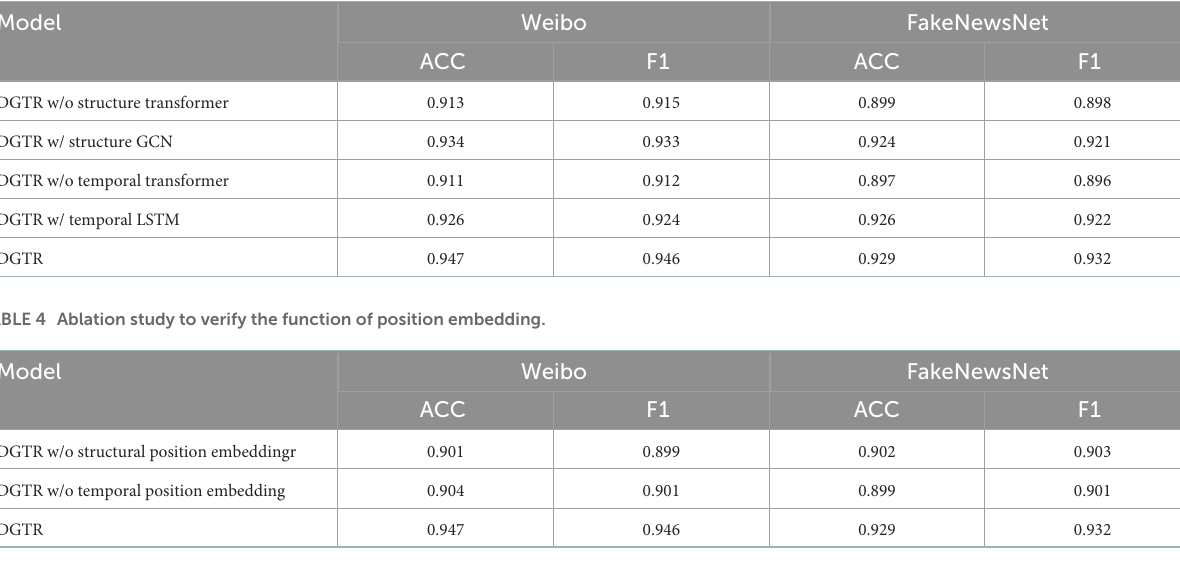
TABLE 3 Ablation study to verify the effectiveness of each component of the model.